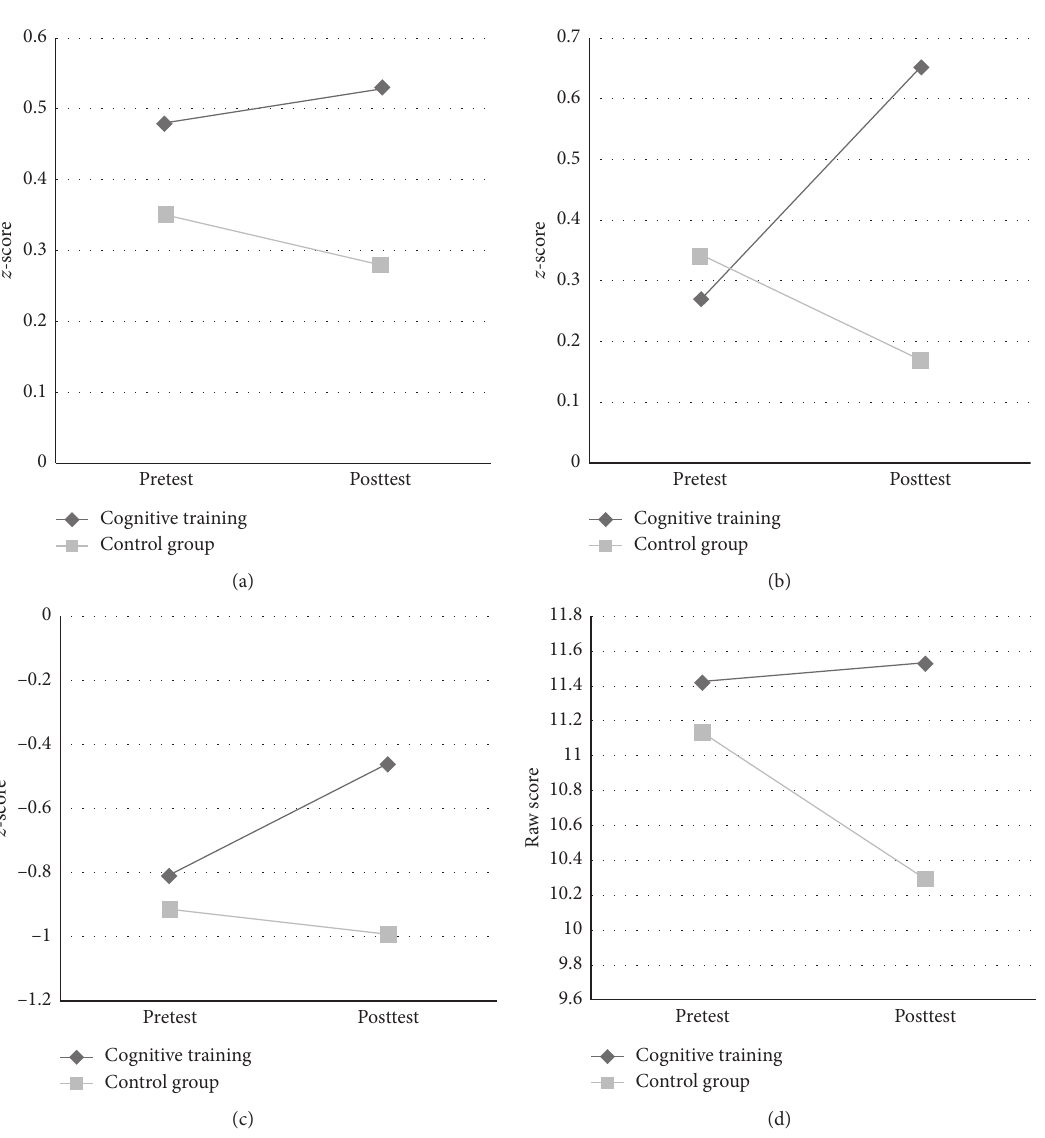
Figure 2: Executive function z -scores at the pre- and posttest for both training groups. Error bars are not illustrated for reasons of clarity; the standard deviations are presented in Table 1. MCST � modified Wisconsin card sorting test. (a) Semantic word fluency, (b) phonemic word fluency, (c) MCST categories, and (d) key